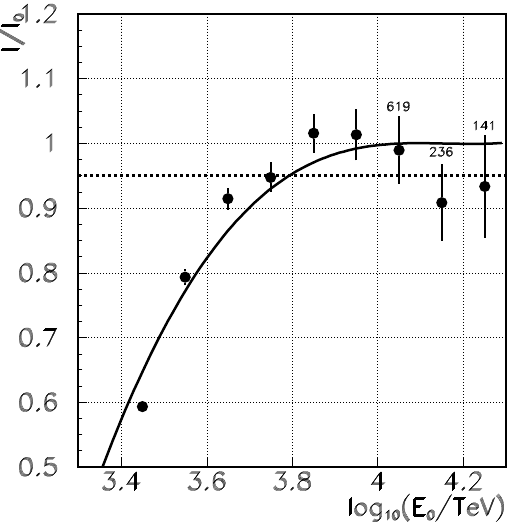
Figure 9. Energy dependence of the EAS registration e ffi ciency in the threshold energy range. Points are the experimental esti- mation from Tunka-25 and Tunka-133 data comparison, the solid line is a result of simulation, the dotted line is the e ffi ciency level for the events used for the spectrum reconstruction.